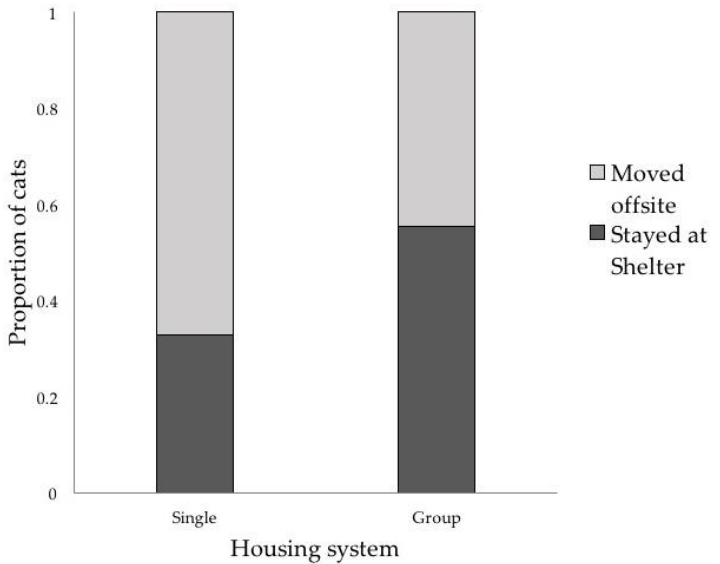
Figure 2. Single-housed cats were 2.5 times more likely to be moved offsite than group-housed